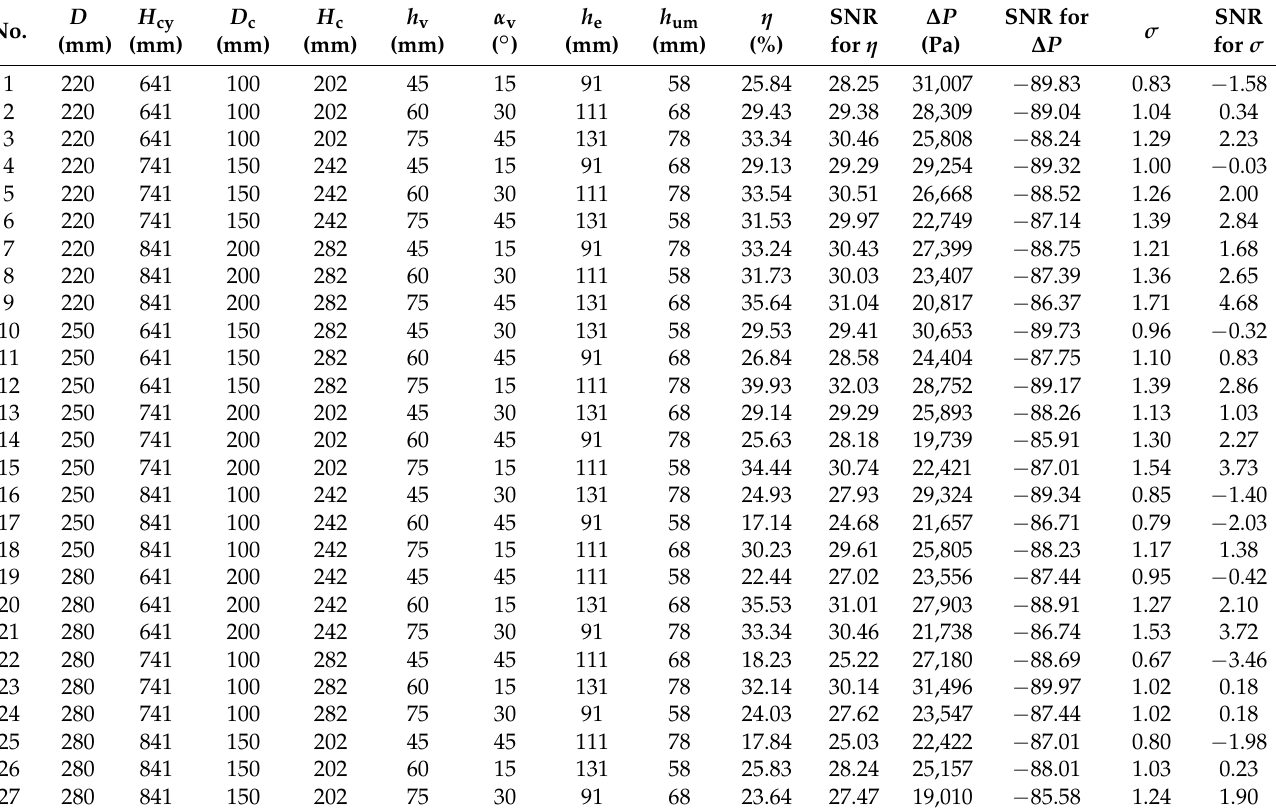
Table 5. L 27 orthogonal array values of the signal-to-noise ratio (SNR) and response